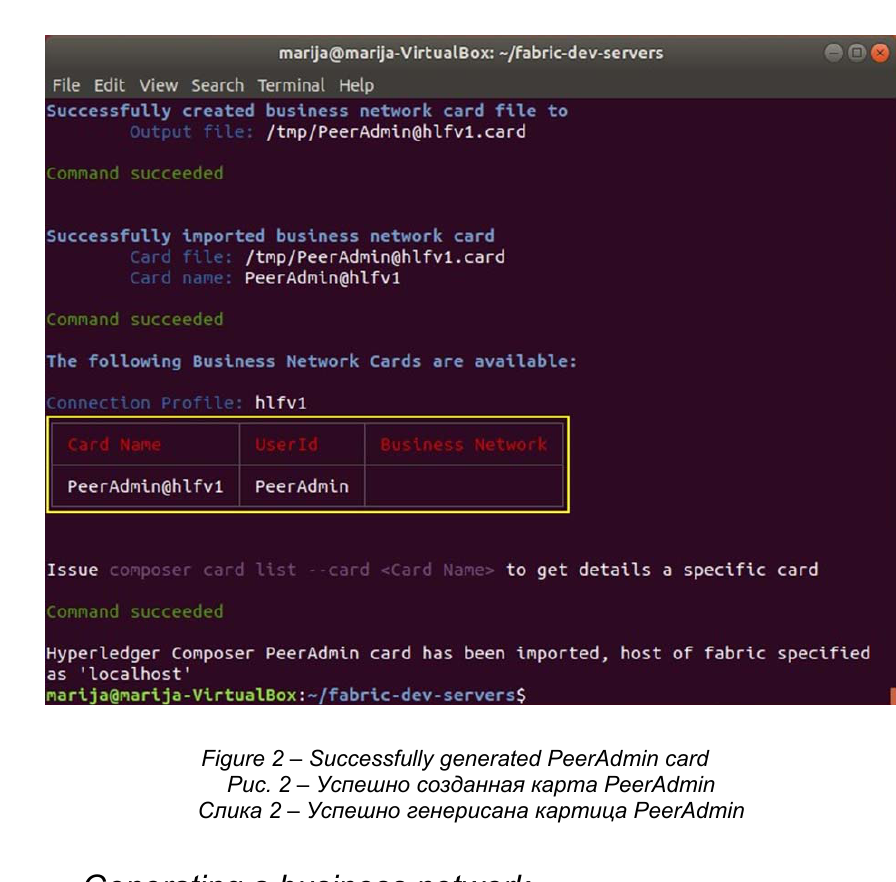
Figure 2 – Successfully generated PeerAdmin